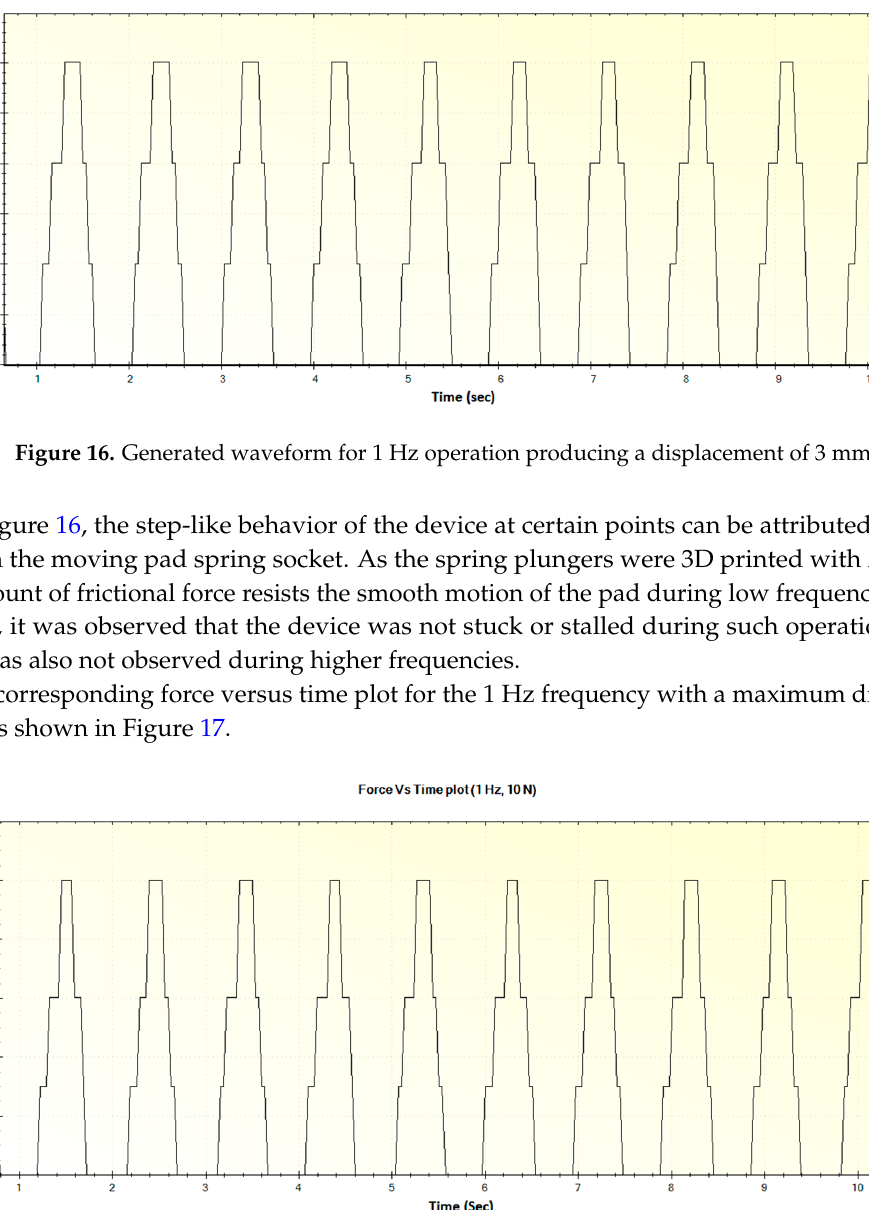
Figure 17. Generated waveform for 1 Hz operation producing a force of 10 N.